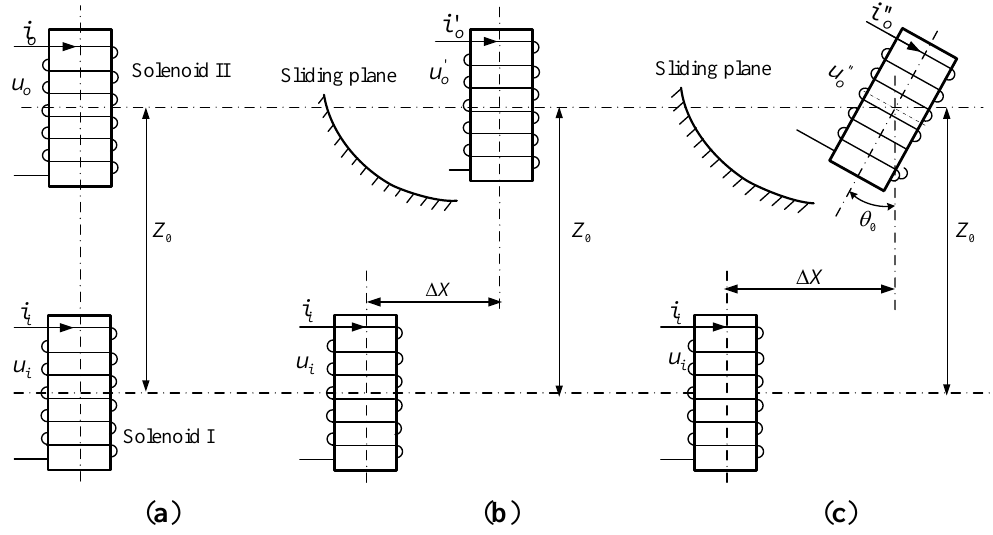
Figure 1. Schematic diagram of the H-type electromagnetic underground displacement sensor. ( a ) Initial geometrical arrangement between Solenoids I and II. ( b ) Occurrence of relative horizontal displacement Δ X . ( c ) Occurrences of both relative horizontal displacement Δ X and axial tilt angle θ . 0